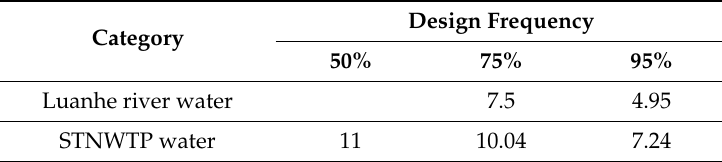
Table 3. Water supply from external diversions in 2030 (units = 10 8 m 3